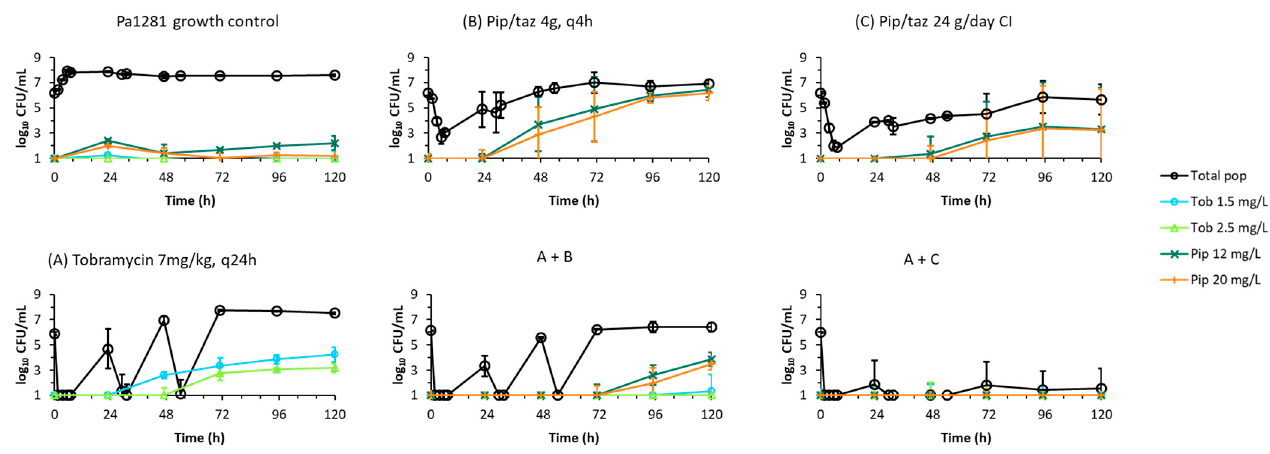
Figure 2. Less susceptible subpopulations of clinical isolate Pa1281 (average ± SE, n = 2) in the dy- namic in vitro infection model quantified on antibiotic-containing agar plates. The total populations (from antibiotic-free agar plates) in each panel below are as shown in Figure 1. Observations below the limit of counting (0.7 log 10 CFU/mL) are plotted at 1.0 log 10 CFU/mL.